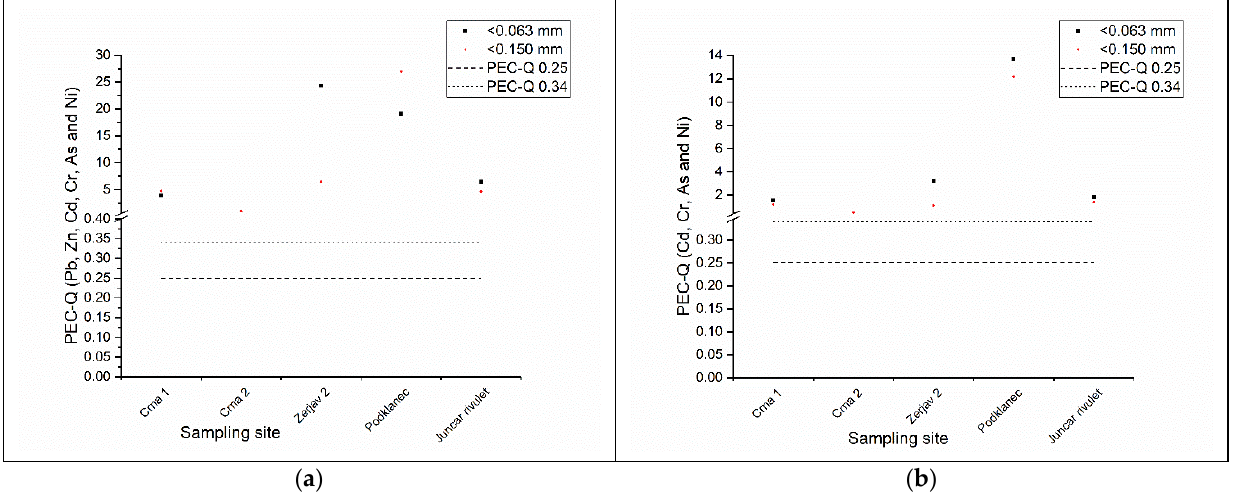
Figure 2. PEC - Q values for sediment samples with ( a ) and without the inclusion of Pb and Zn ( b ), collected along the Meža River and its tributaries. Horizontal lines correspond to PEC - Q values of 0.25 and 0.34.